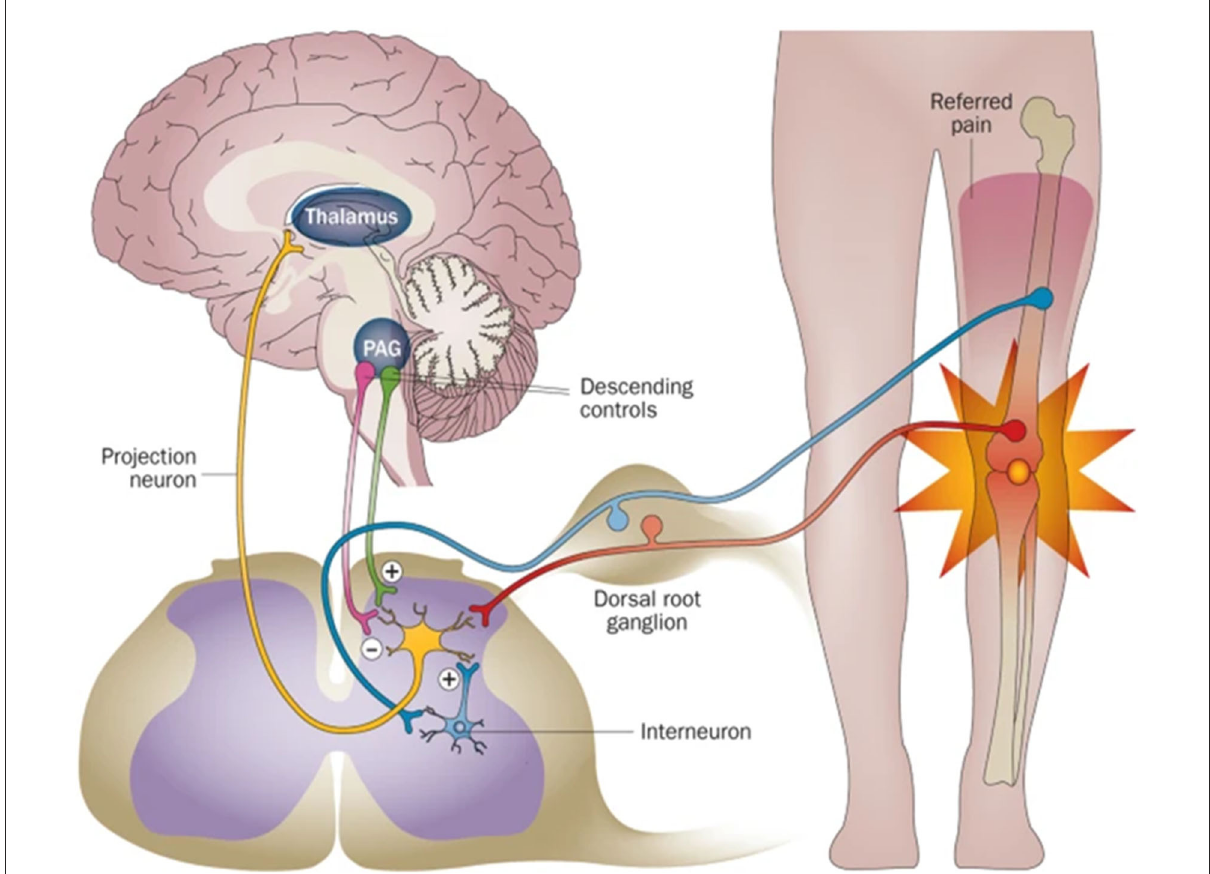
FIGURE1 The scheme of the relationship between the nerve system and bone. PNS acts as a relay station to transmit information between CNS and the bone. Reprinted from Thakur et al. (7) with permission from Springer Nature.